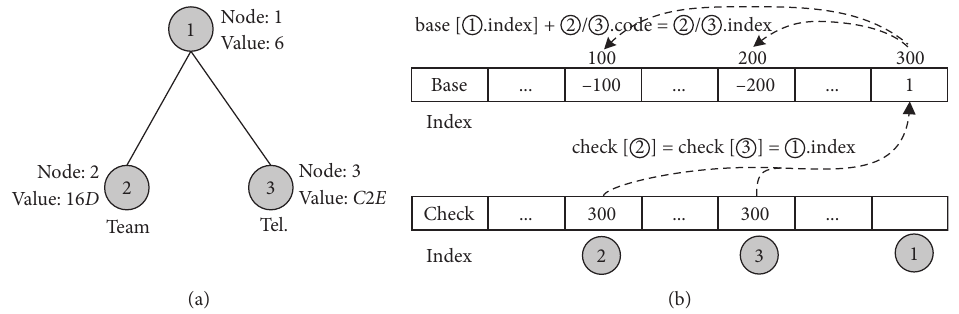
Figure 7: Example of a double-array ATree. (a) Logic structure. (b) Implementation of double